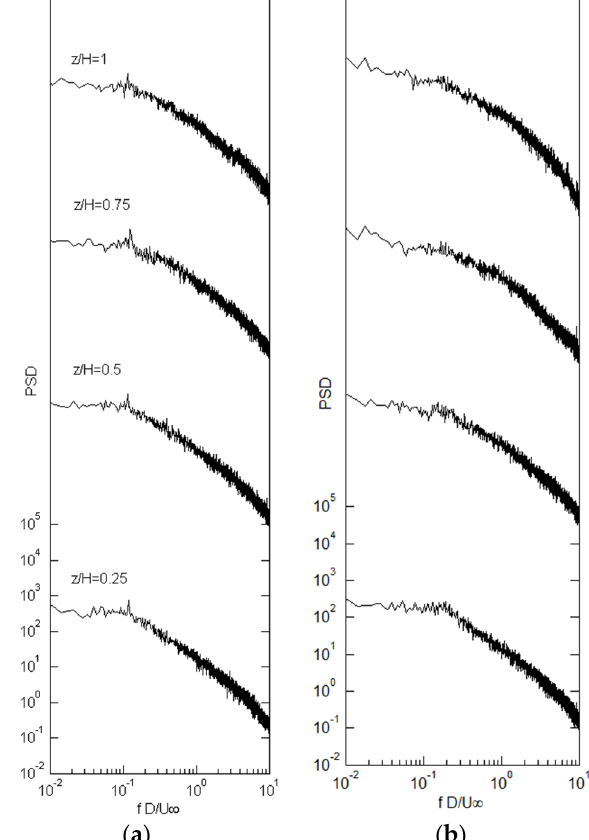
Figure 6. The power-spectral-density function of the streamwise velocity at x / H = 1 and y / H = 1 for: ( a ) cube, ( b ) cylinder. Each spectrum is the average of 20 individual spectra. Spectra are offset by constant factor for clarity.